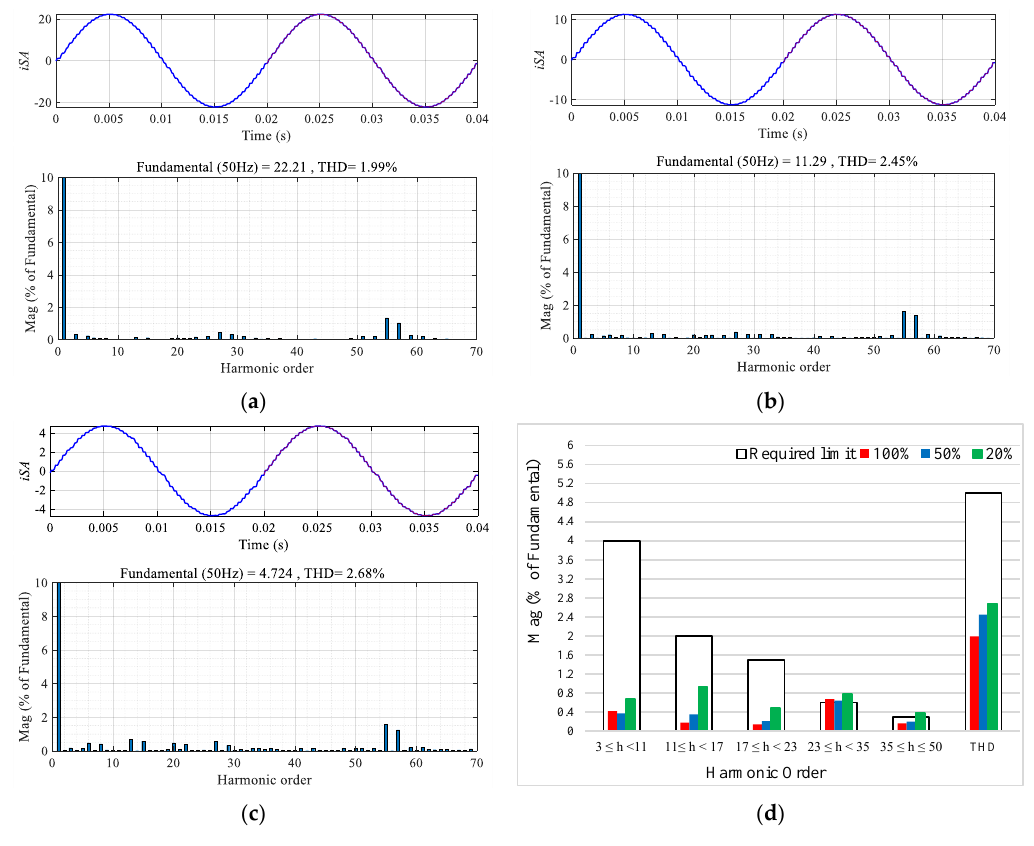
Figure 14. The line input current of the proposed 56-PR and its spectrum under ( a ) 100%, ( b ) 50%, ( c ) 20% of the rated power and ( d ) harmonic current limits (% of fundamental) for a 10-kW load. Figure 15 shows the response of the output voltage and input/output current wave- forms to step-load changes. The amplitude of transients depends on the amplitude load change and the inductance of the source. The proposed 56-PR can successfully track load changes.